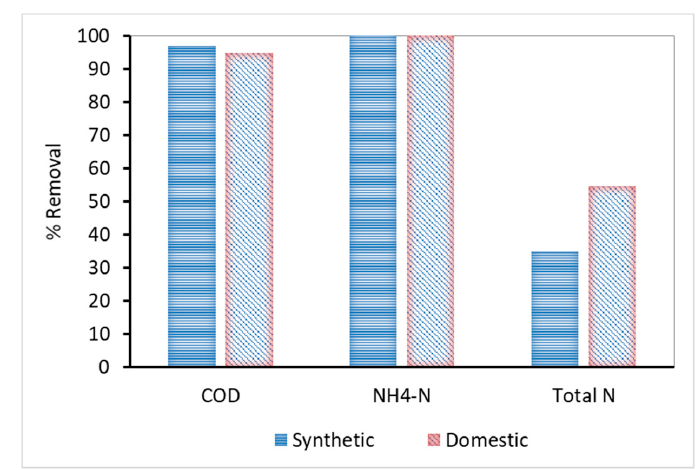
Figure 2. COD, NH 4 -N and total N percentage removal for synthetic and domestic wastewater.